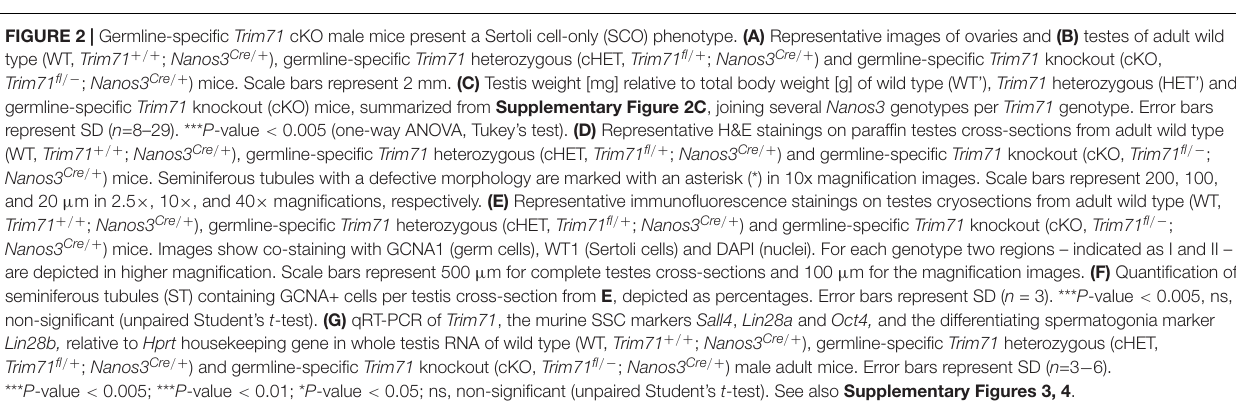
FIGURE 2 | Germline-specific Trim71 cKO male mice present a Sertoli cell-only (SCO) phenotype. (A) Representative images of ovaries and (B) testes of adult wild type (WT, Trim71 + / + ; Nanos3 Cre / + ), germline-specific Trim71 heterozygous (cHET, Trim71 fl / + ; Nanos3 Cre / + ) and germline-specific Trim71 knockout (cKO, Trim71 fl / − ; Nanos3 Cre / + ) mice. Scale bars represent 2 mm. (C) Testis weight [mg] relative to total body weight [g] of wild type (WT’), Trim71 heterozygous (HET’) and germline-specific Trim71 knockout (cKO) mice, summarized from Supplementary Figure 2C , joining several Nanos3 genotypes per Trim71 genotype. Error bars represent SD ( n =8–29). *** P -value < 0.005 (one-way ANOVA, Tukey’s test). (D) Representative H&E stainings on paraffin testes cross-sections from adult wild type (WT, Trim71 + / + ; Nanos3 Cre / + ), germline-specific Trim71 heterozygous (cHET, Trim71 fl / + ; Nanos3 Cre / + ) and germline-specific Trim71 knockout (cKO, Trim71 fl / − ; Nanos3 Cre / + ) mice. Seminiferous tubules with a defective morphology are marked with an asterisk (*) in 10x magnification images. Scale bars represent 200, 100, and 20 µ m in 2.5 × , 10 × , and 40 × magnifications, respectively. (E) Representative immunofluorescence stainings on testes cryosections from adult wild type (WT, Trim71 + / + ; Nanos3 Cre / + ), germline-specific Trim71 heterozygous (cHET, Trim71 fl / + ; Nanos3 Cre / + ) and germline-specific Trim71 knockout (cKO, Trim71 fl / − ; Nanos3 Cre / + ) mice. Images show co-staining with GCNA1 (germ cells), WT1 (Sertoli cells) and DAPI (nuclei). For each genotype two regions – indicated as I and II – are depicted in higher magnification. Scale bars represent 500 µ m for complete testes cross-sections and 100 µ m for the magnification images. (F) Quantification of seminiferous tubules (ST) containing GCNA+ cells per testis cross-section from E , depicted as percentages. Error bars represent SD ( n = 3). *** P -value < 0.005, ns, non-significant (unpaired Student’s t -test). (G) qRT-PCR of Trim71 , the murine SSC markers Sall4 , Lin28a and Oct4, and the differentiating spermatogonia marker Lin28b, relative to Hprt housekeeping gene in whole testis RNA of wild type (WT, Trim71 + / + ; Nanos3 Cre / + ), germline-specific Trim71 heterozygous (cHET, Trim71 fl / + ; Nanos3 Cre / + ) and germline-specific Trim71 knockout (cKO, Trim71 fl / − ; Nanos3 Cre / + ) male adult mice. Error bars represent SD ( n =3 −